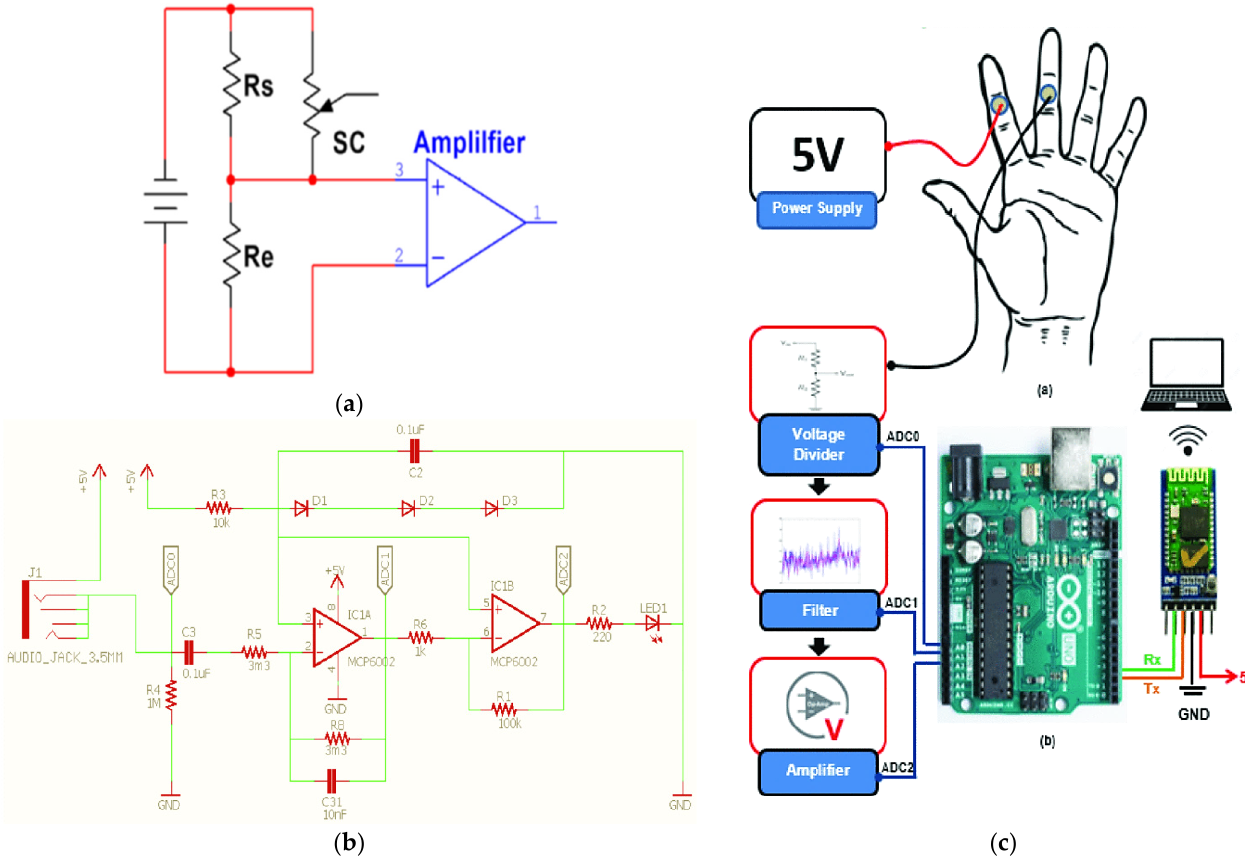
Figure 10. ( a ) Skin conductance measurement circuit using the exosomatic method; ( b ) scheme of the galvanic skin response circuit; ( c ) electrode positioning on the hand (up) and block diagram of typical galvanic skin response (down) [45] (Reprinted with permission from ref. [45]. Copyright 2021 IEEE).